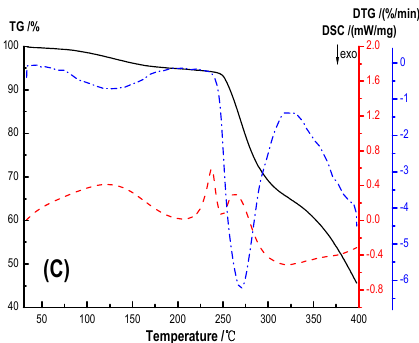
Figure 9. TG-DSC (Thermogravimetric differential thermal analyze) curves of Hydrogels, ( A ) PVA, ( B ) AS0, and ( C ) AS50.